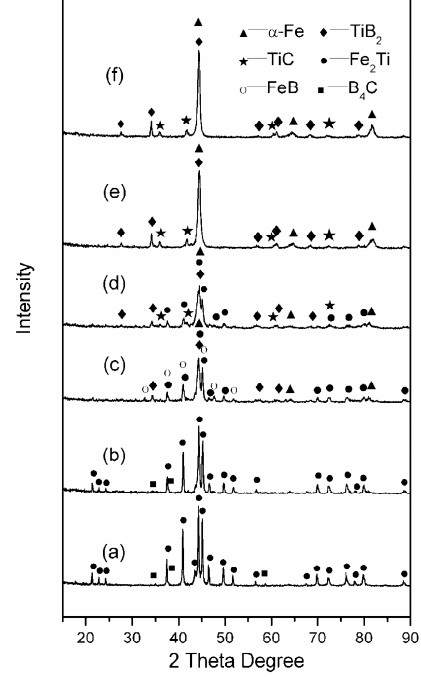
Figure 10. XRD patterns for ( a ) room temperature and sintering at ( b ) 1073, ( c ) 1173, ( d ) 1223, ( e ) 1273, and ( f ) 1323 K (reprinted from Fabrication of in situ TiB2–TiC reinforced steel matrix composites by spark plasma sintering, B H Li, Y Liu, J Li, H Cao & L He, Powder Metallurgy, copyright © Institute of Materials, Minerals and Mining, reprinted by permission of Taylor & Francis Ltd., http://www.tandfonline.com (accessed on 27 October 2022) on behalf of Institute of Materials, Minerals and Mining).